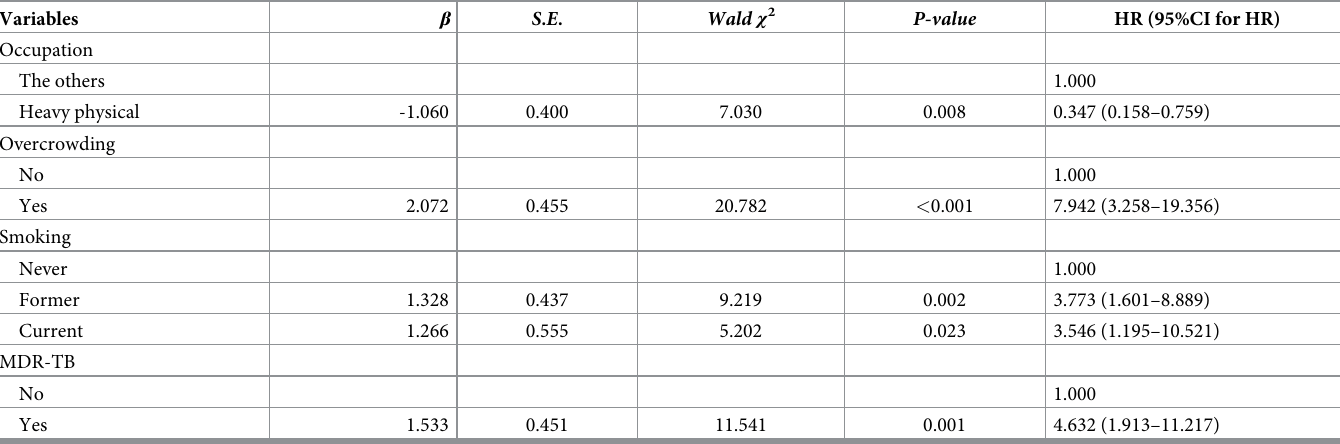
Table 4. Multivariable Cox regression of factors influencing survival of TB patients in Liberia (n = 337).